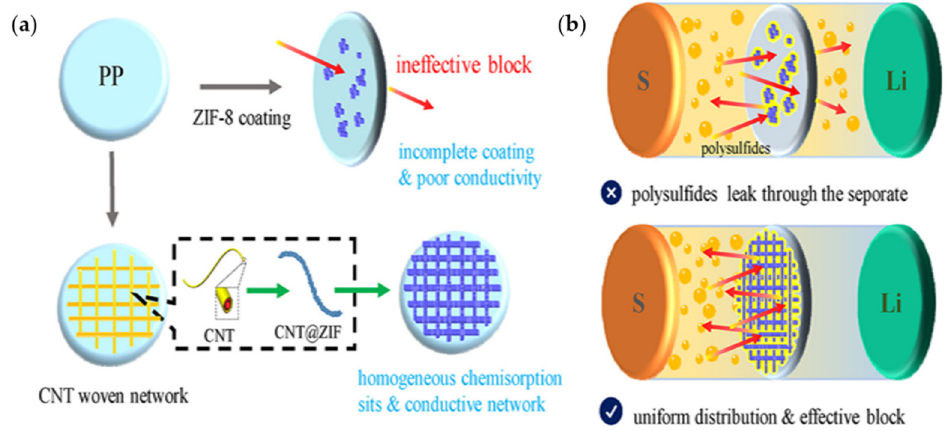
Figure 13. ( a ) Schematics of ZIF-8 and the CNT@ZIF composite modified separators ( b ) Li-S battery configuration with the modified separators. Reprinted with permission from [142]. Copyright (2018) Elsevier B.V.